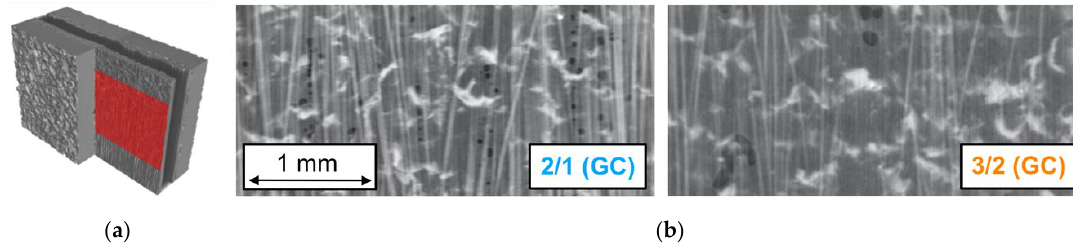
Figure 9. Computed tomography cross-section images showing pore occurrence between the mechanically blasted aluminium surface and the GFR-PA6 layer in hybrid laminates, ( a ) red plane visualizes displayed cross-section plane; ( b ) cross-section image for the layer structure/metal volume content (MVC) 2/1 (GC) with 61% and 3/2 (GC) with 54%.